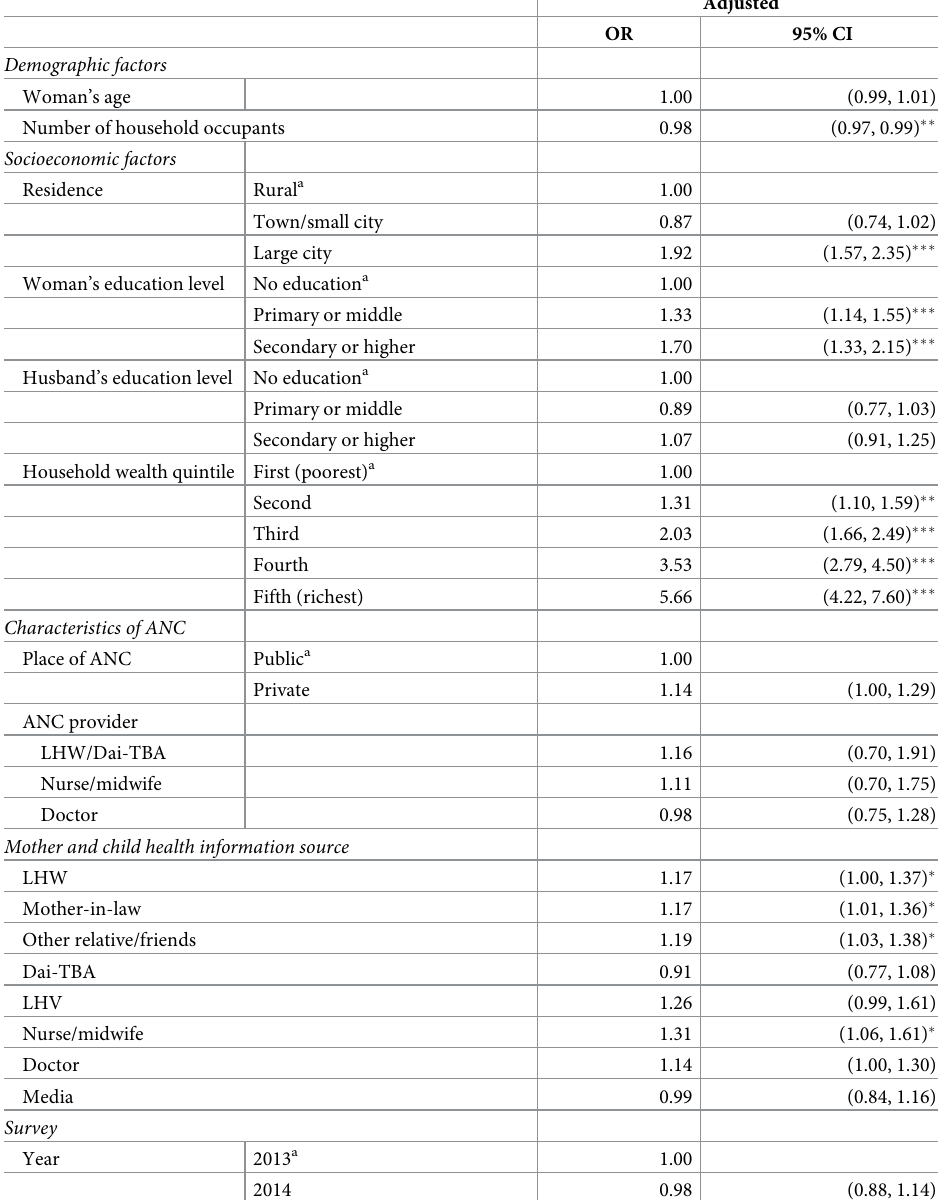
Table 2. Logistic regression for making at least four antenatal care visits (n =